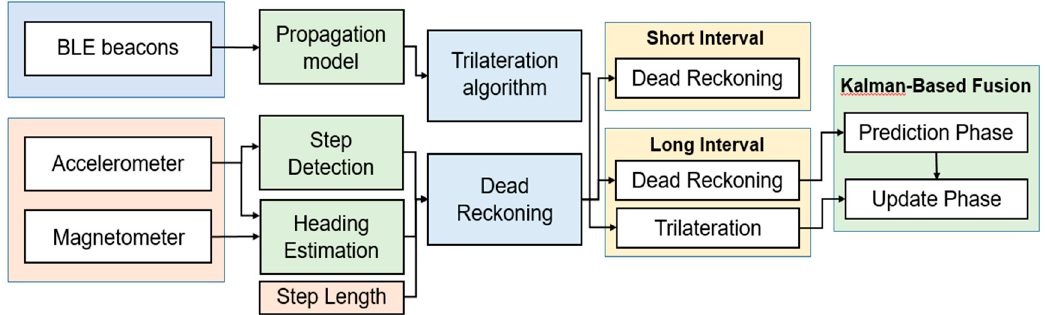
Figure 6. The processing pipeline of the hybrid indoor positioning.